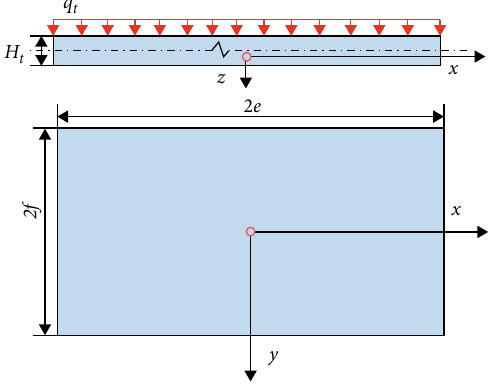
Figure 3: Mechanical model of initial permafrost